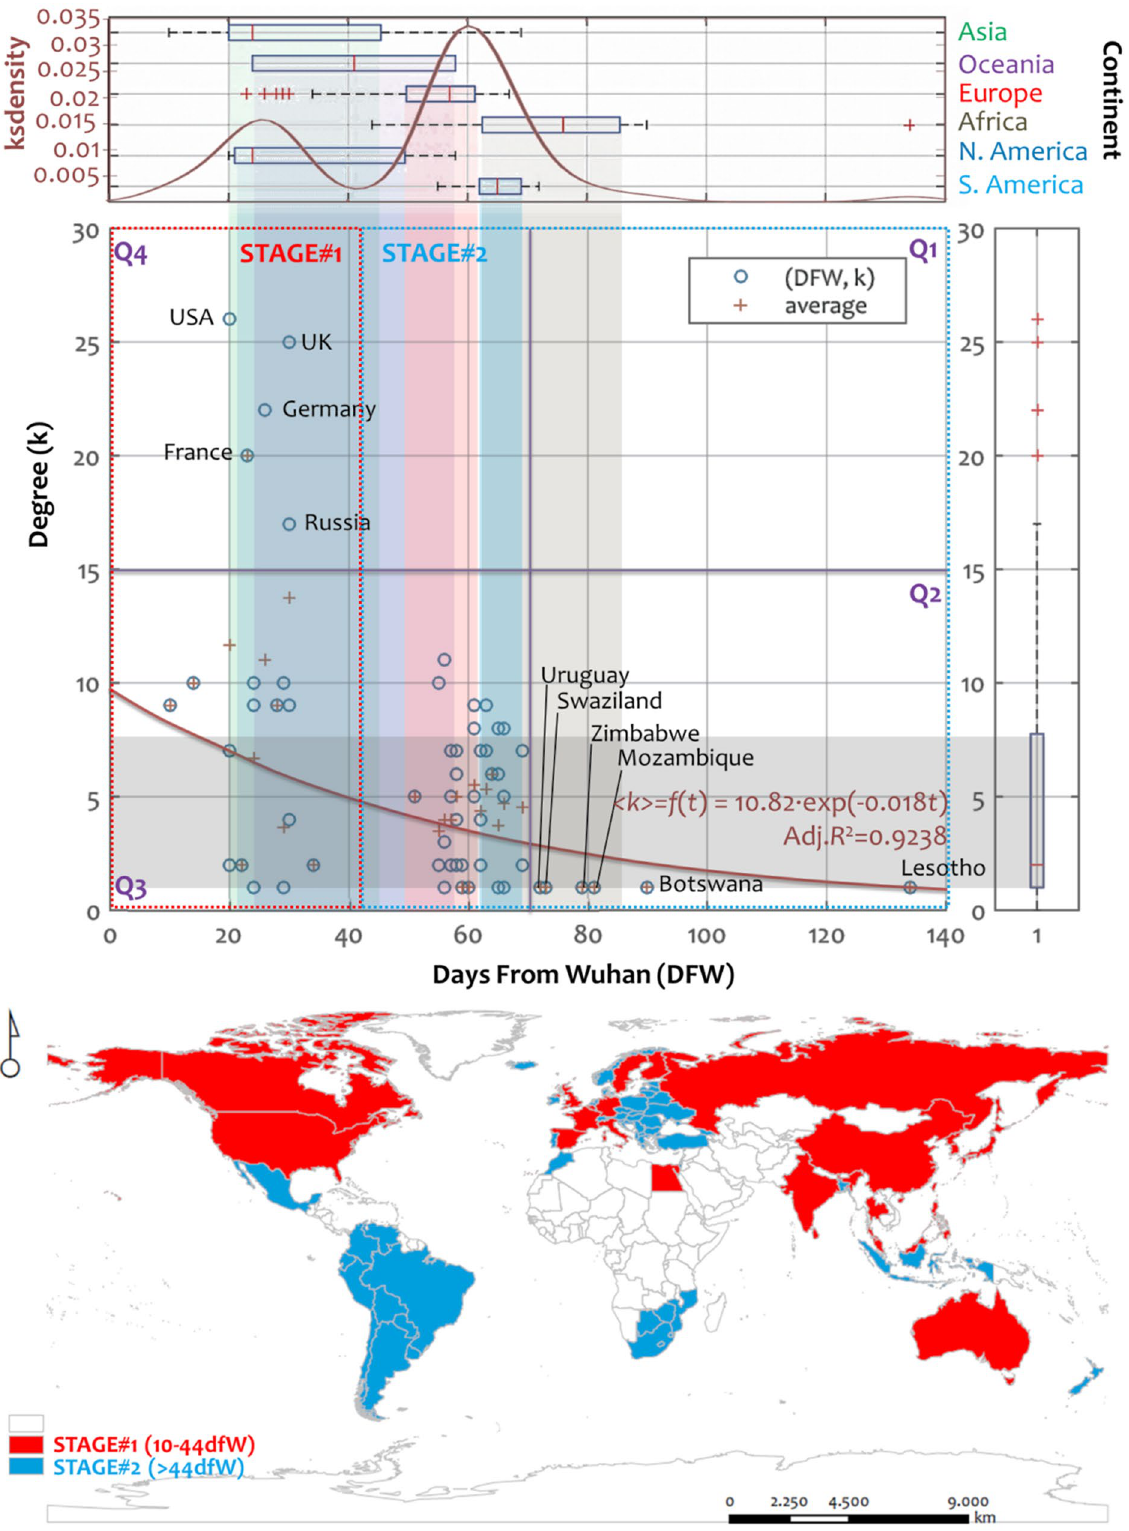
Figure 4. Multilayer scatterplot ( DFW , k ) showing the correlation between the days since the first infection from Wuhan ( DFW ) and the node-degree ( k ) of the GTN. Boxplots in each axis illustrate the distribution of each variable, where DFW further separates into continent groups. Shaded zones within the scatterplot express interquartile ranges of each boxplot. Quadrants Q 1 , Q 2 , Q 3 , and Q 4 in the scatterplot area correspond to median lines. The fitting curve f ( x ) is applied to average degree values (< k >), expressed by cross “+” symbols. At the bottom, the map shows the spatial distribution of the two stages defined by the ks -density curve (maps are own elaboration based on ESRI ArcGIS 10.50; https:// www. arcgis.